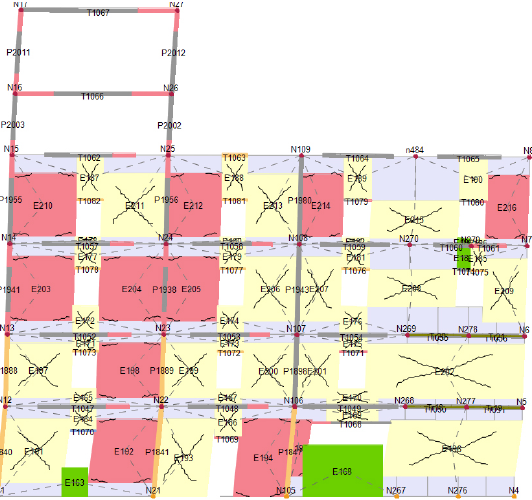
Figure 21. Structural damage wall n.3 at the last step of seismic analysis n.21, direction Y